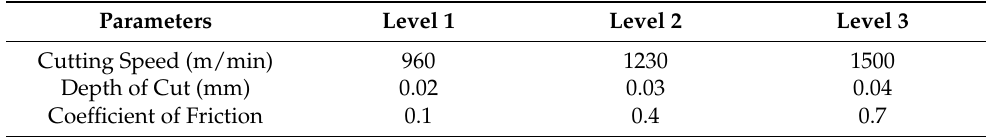
Table 2. Process parameters and their